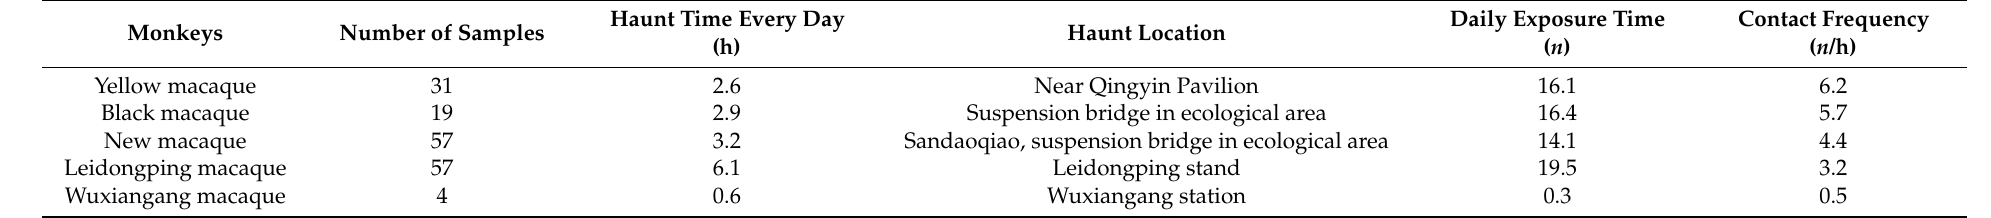
Table 2. Contact frequency of different groups of macaques with